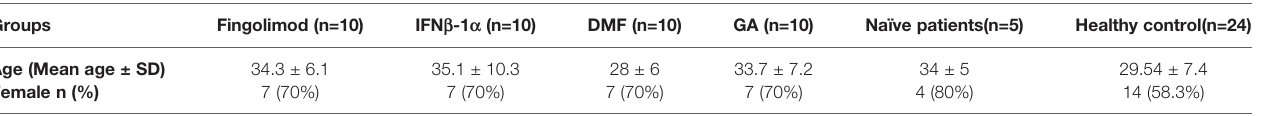
TABLE 3 | Classi fi cation based on the sex and